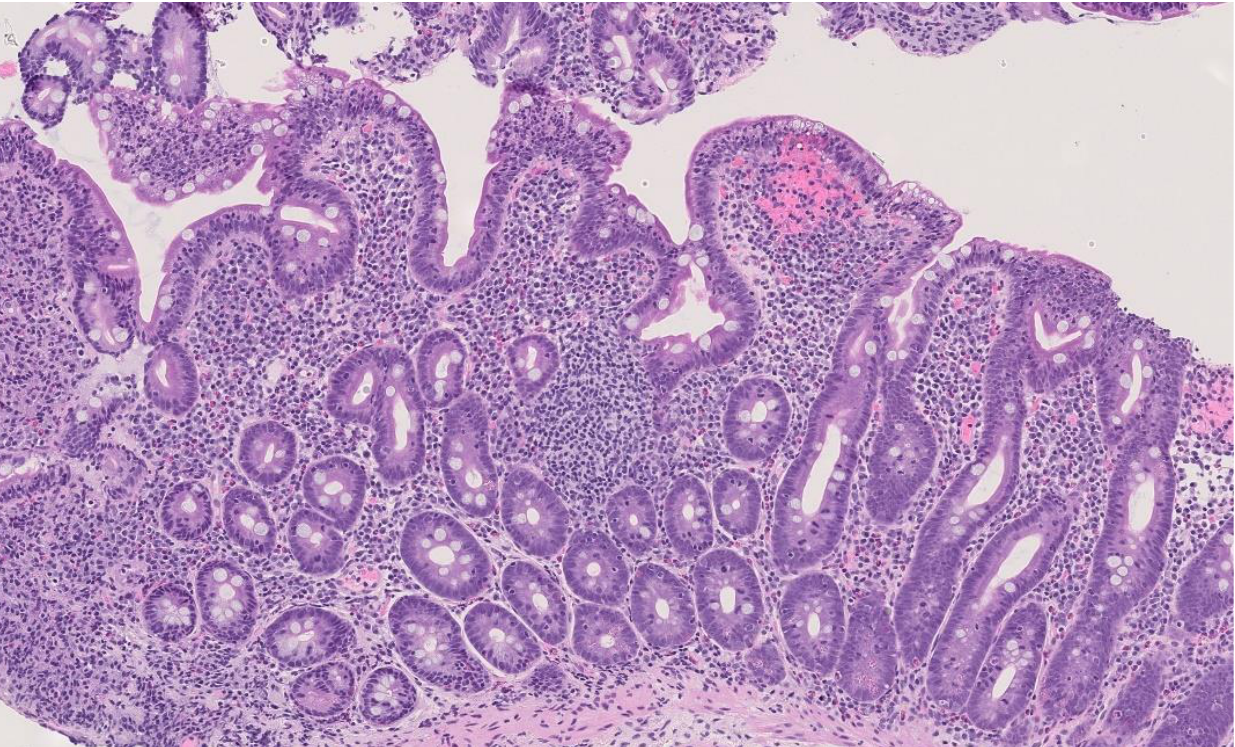
Figure 3, the histological evaluation of the duodenal biopsy is shown.